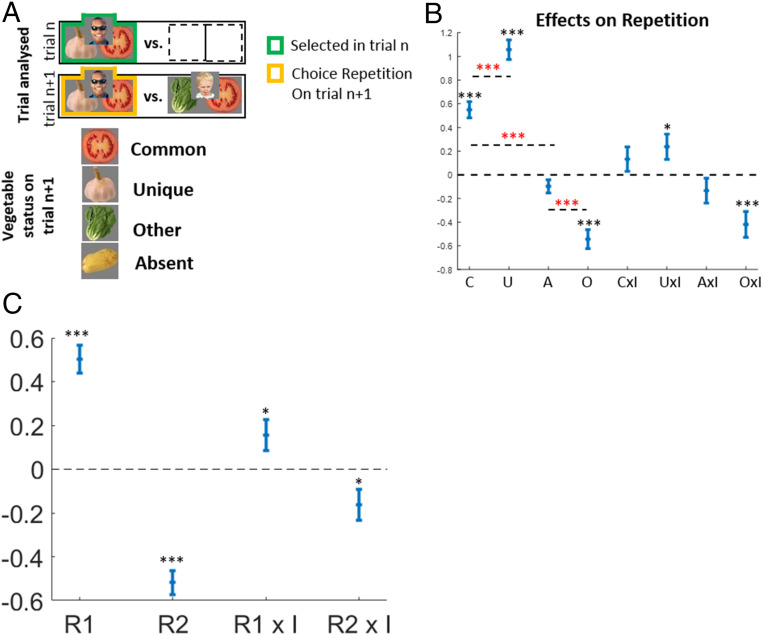
Signatures of MFCA and MBCA. (A) We analyzed a subset of trials that included on trial n+1 the person chosen on trial n. For clarity, we represent people by their associated pair of vegetables; in the actual experiment, participants saw images of the people alone. Places for nonchosen persons on trial n are left empty. We classified the four outcomes as Common, Unique, Other, and Absent. (B) Empirical effects on choice repetition. The positive Common-outcome main effect is a signature of MFCA to the chosen person based on choice-related outcomes. The positive difference between the Unique and Common effects is a signature of MBCA to choice-related outcomes. Similarly, the positive difference between the Absent and Other (labeled O) effects is a signature of MBCA to choice-unrelated outcomes. The difference between the effects of the Common and Absent outcomes is a signature of CM guidance to MFCA. The interactions between outcome-importance (labeled I) and Unique and Other outcomes are signatures that MBCA is enhanced for important, relative to nonimportant, outcomes (Fig. S2 and S4 for validating simulations). (C) Empirical regression effects of a trial n reward (versus nonreward) for the vegetable distinctive to the trial n+1 right-side (R1) or left-side (R2) person on right-side choices. The interaction of these rewards with the importance (denoted I) of these two vegetables on trial n is a signature of importance-based modulation of MBCA (SI Appendix, Fig. S3 for validating simulations). Error bars correspond to SEM across participants calculated separately in each condition (n = 42). *P < 0.05, ***P < 0.001. Red asterisks correspond to contrasts of effects. P values were calculated based on mixed-effects logistic regression models.